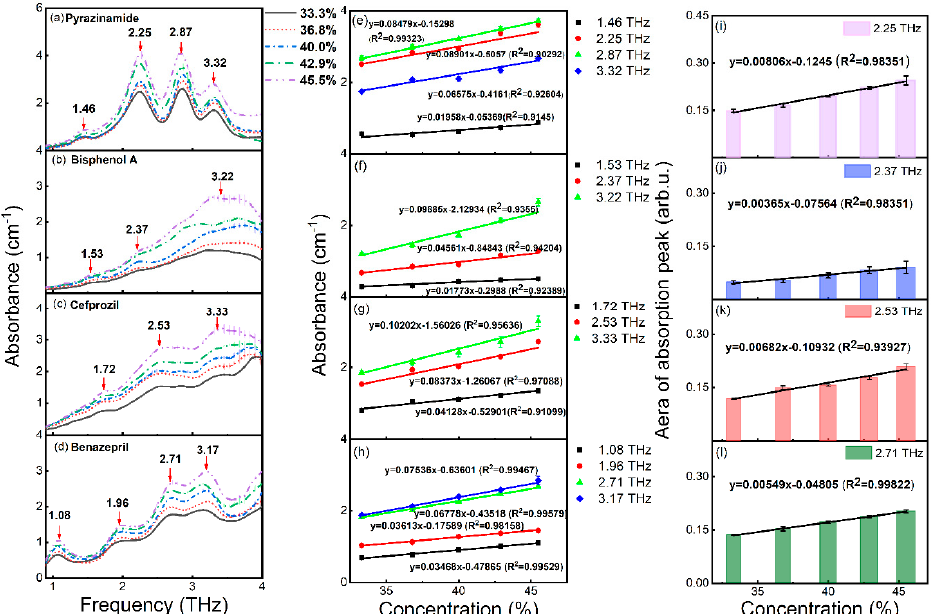
Figure 3. THz absorption spectra of ( a ) pyrazinamide, ( b ) bisphenol A, ( c ) cefprozil, and ( d ) benazepril under five different concentrations. The absorbance of absorption peaks for different concentrations of ( e ) pyrazinamide, ( f ) bisphenol A, ( g ) cefprozil, and ( h ) benazepril. The area under the absorption peaks of ( i ) pyrazinamide, ( j ) bisphenol A, ( k ) cefprozil, and ( l ) benazepril. The corresponding error bars have been labelled.